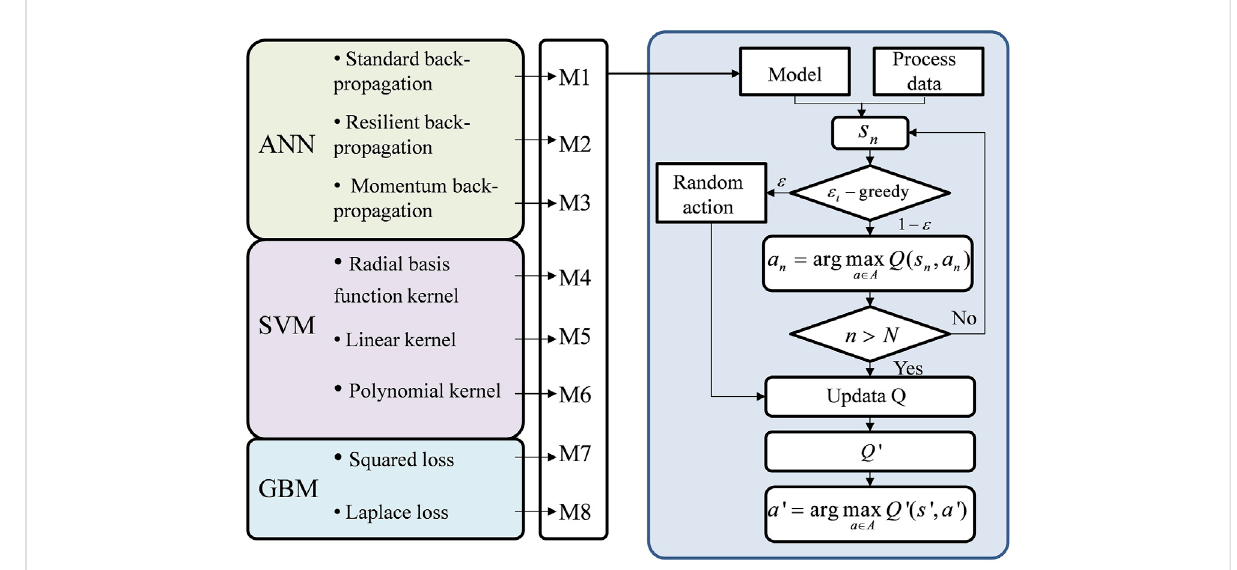
FIGURE 3 Model selection and parameter update method based on Q-learning